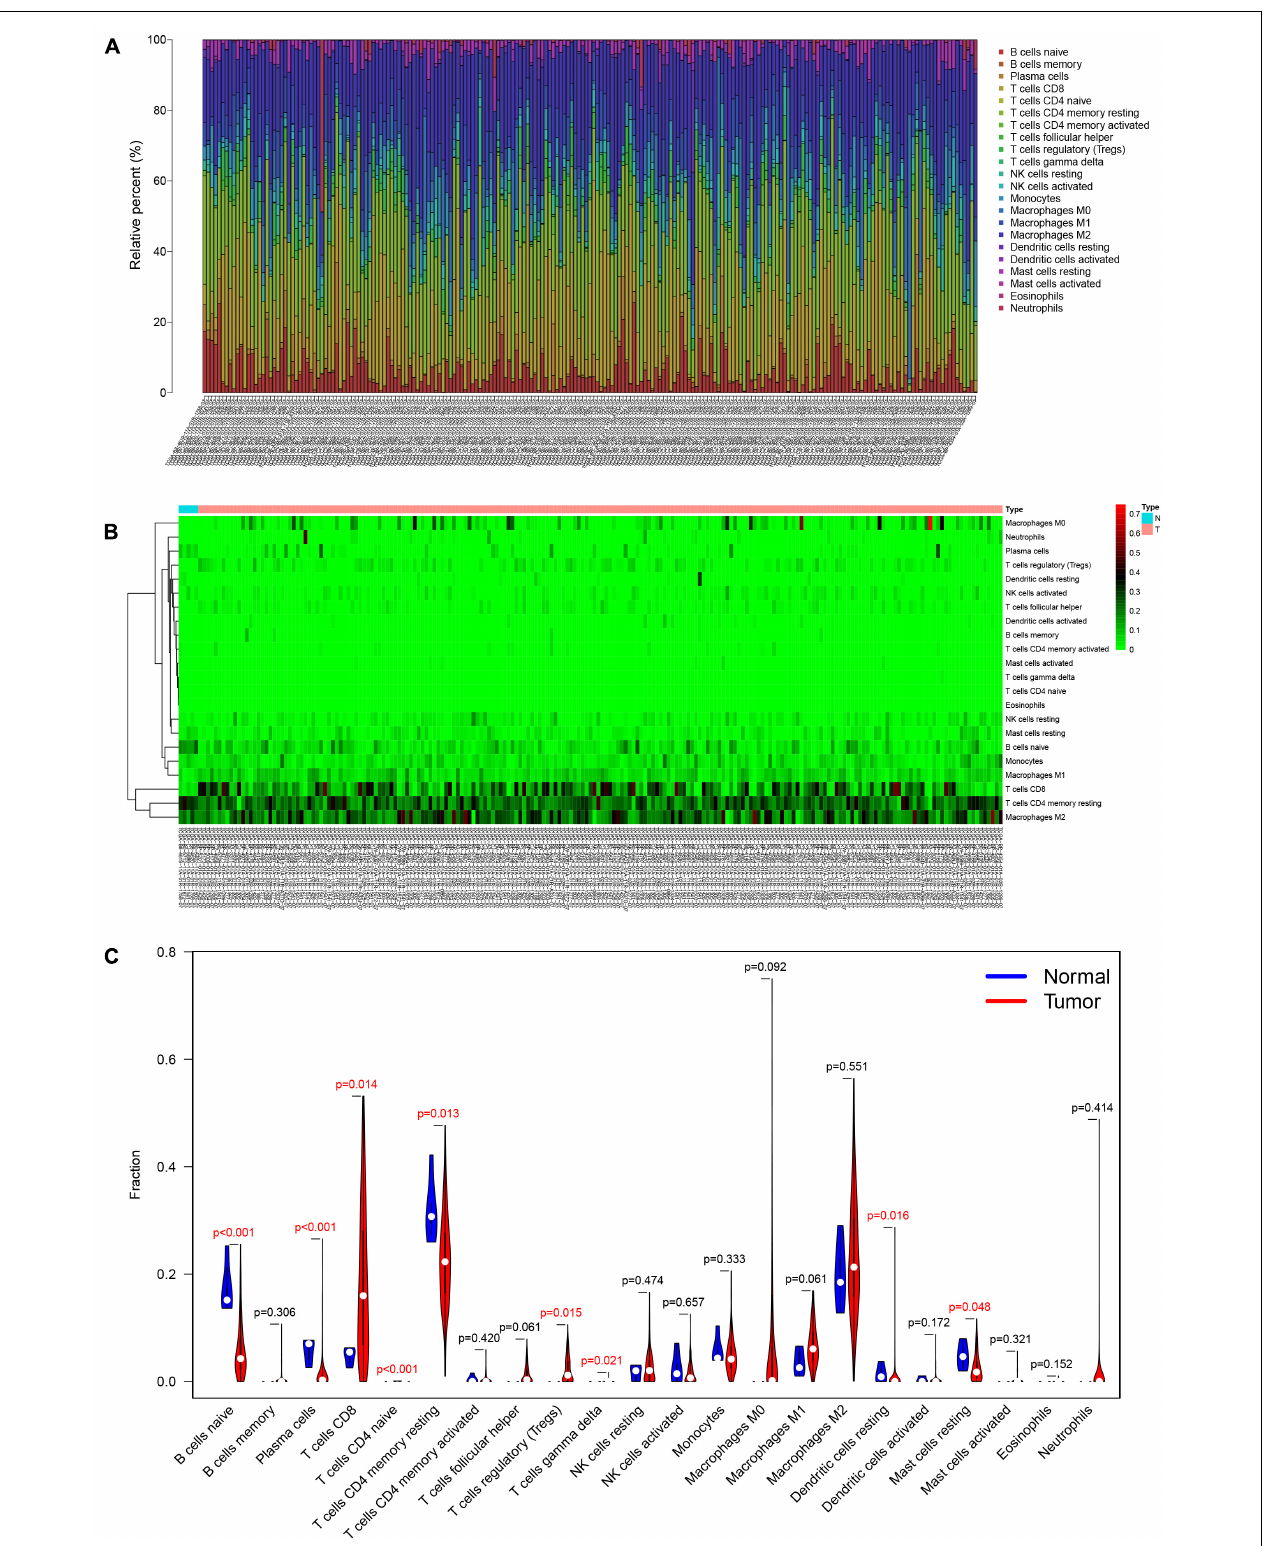
FIGURE 5 | The composition (A) and heatmap (B) of immune cells estimated by the CIBERSORT algorithm in five normal adjacent tissues and 206 KIRC tissues. The violin plot of immune cells (C) compares cells’ proportion between the two groups.